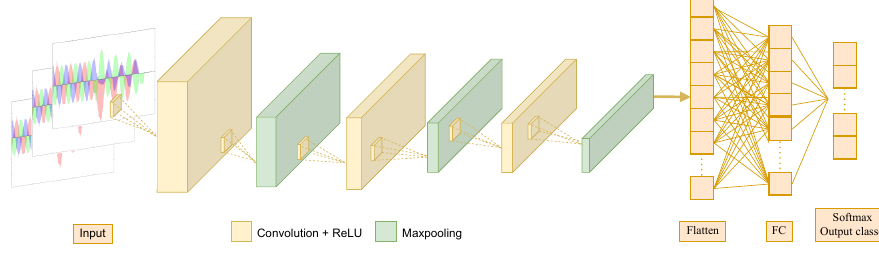
Figure 4. Structure of the proposed CNN